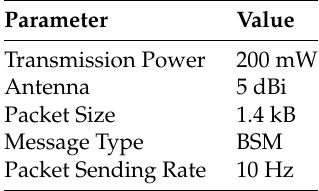
Table 1. Simulation